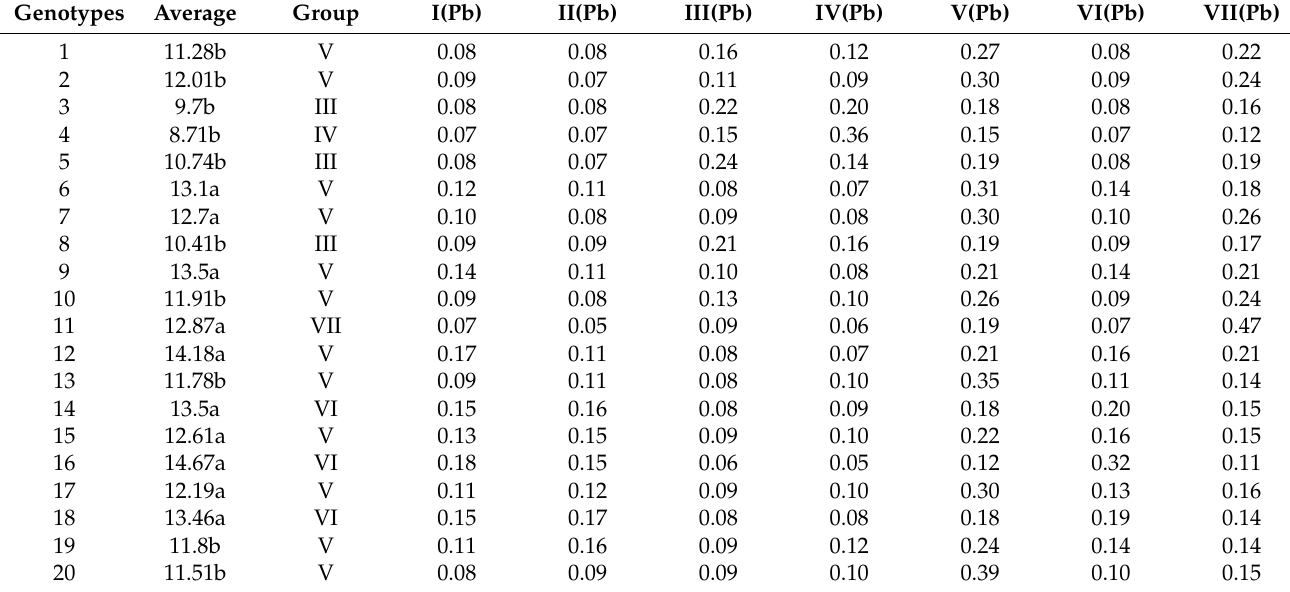
Table 10. Estimates of sugar productivity, classification of sugarcane genotypes in one of the seven groups proposed by the modified centroid method and probability associated with the classification of each genotype.